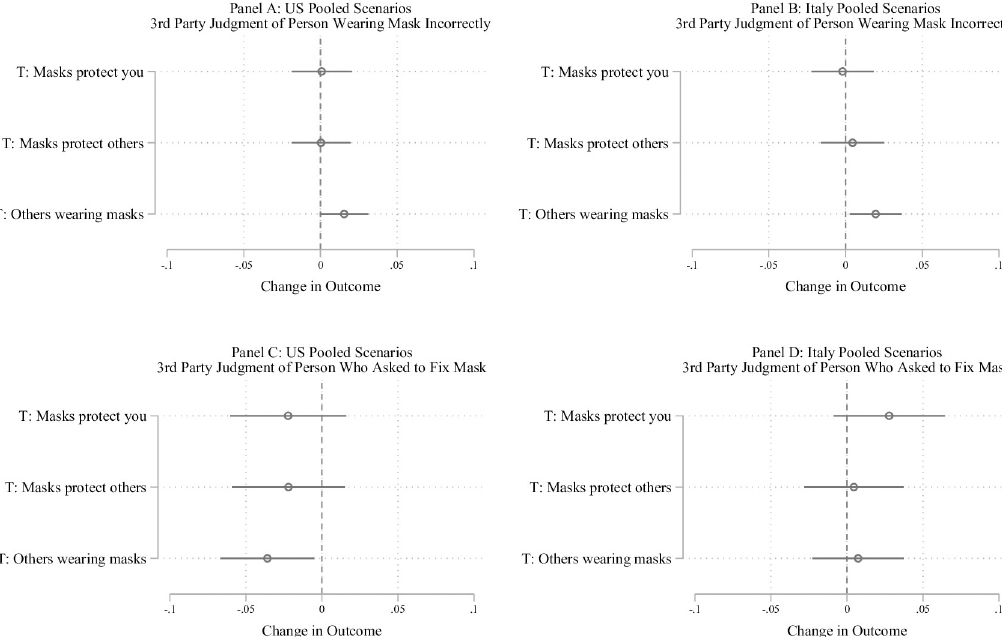
Fig 3. Effect of beliefs and prevalence of mask wearing on third party judgment. Panels A and B show the effect of the mask efficacy treatments and social norms treatment for judging someone who was not wearing their mask appropriate in the THIRD PARTY scenario. Panels C and D show the effect of these treatments for judging someone who asked a person to fix their mask in the THIRD PARTY scenario. The figure displays OLS regression estimates with 95% confidence intervals. Models include covariates described in S3 Appendix. Italian participants were more likely to judge negatively someone who was not wearing their mask properly when everyone else was wearing their mask properly, while participants in the United States viewed someone who asked another person to fix their mask more positively when everyone else was wearing their mask properly. The mask efficacy treatments did not have statistically significant effects on these outcomes.